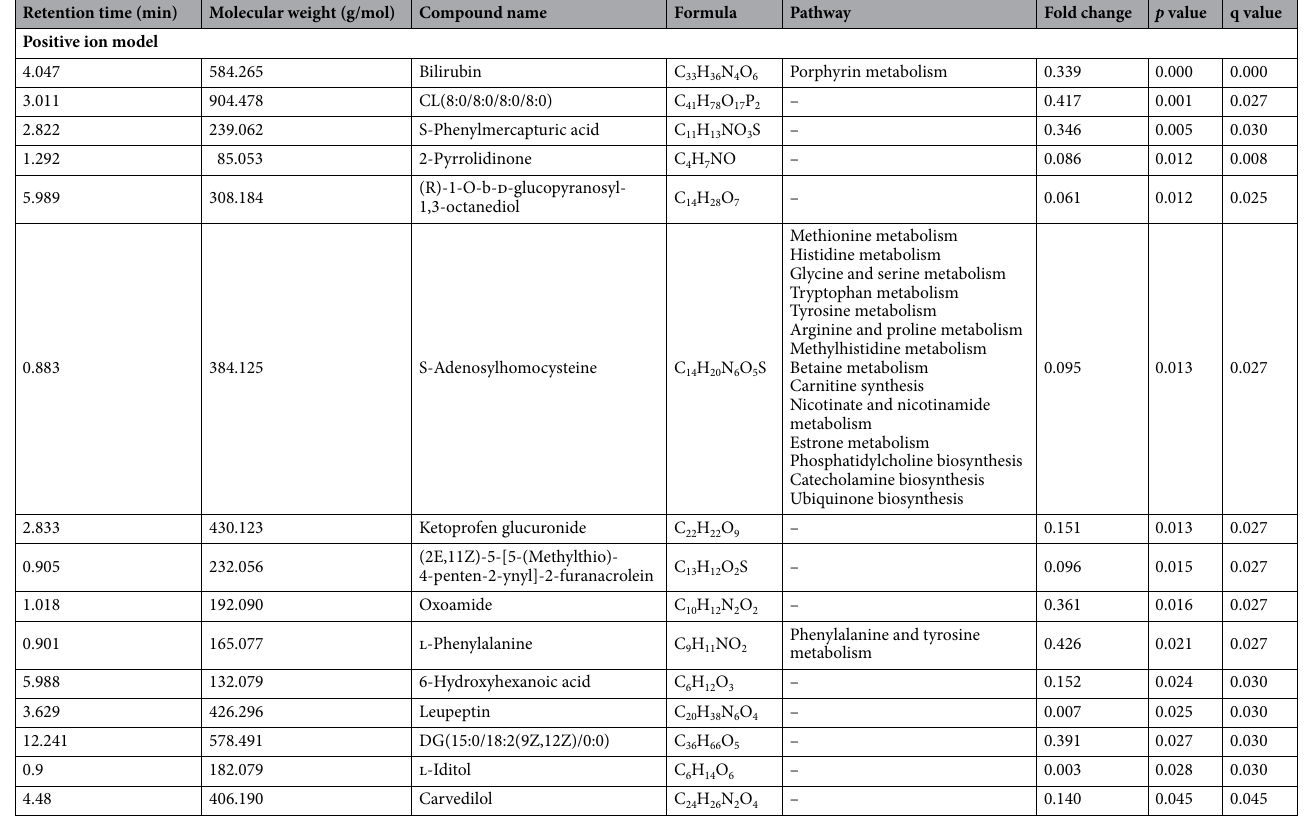
Table 3. Identified metabolites in positive ion model related to NC-AME based on UPLC-Q-TOF/MS. Q-values are the adjusted p values using an optimized FDR